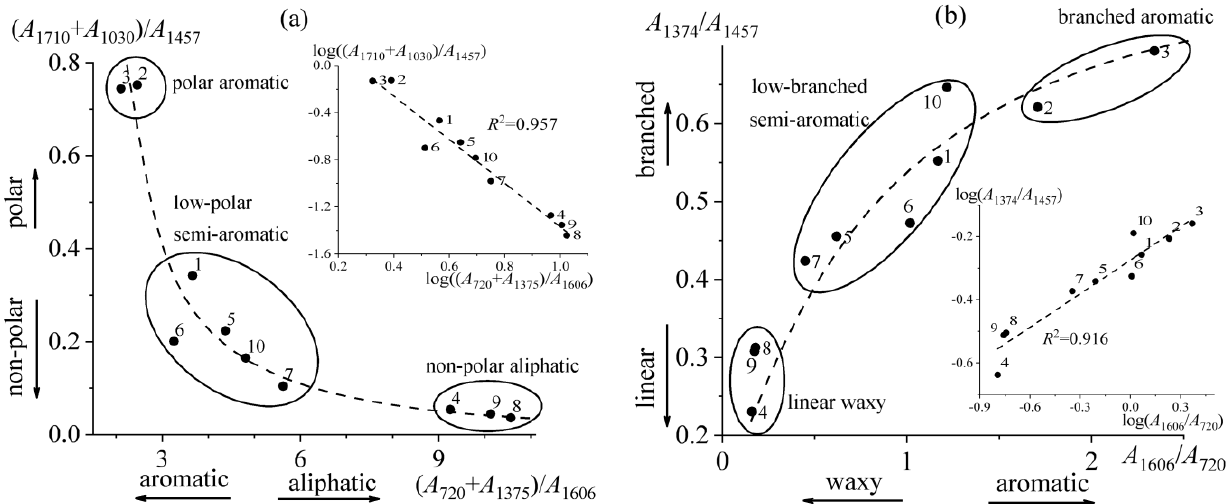
Figure 3. Mutual dependences of bitumen spectral characteristics: ( a ) polarity vs. paraffinicity and ( b ) branchiness vs. aromaticity. Bitumen numbers are indicated near the experimental points. The insets show the same dependencies in logarithmic coordinates.